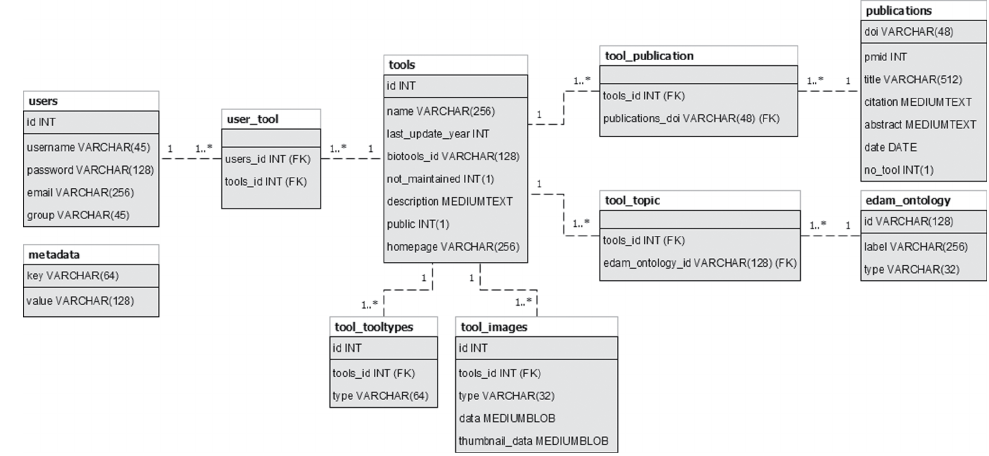
Figure 1: Database schema for JIB.tools 2.0 with the main entities tool, publication, and user. Additional information like types, topics, and images are linked via foreign keys to their respective